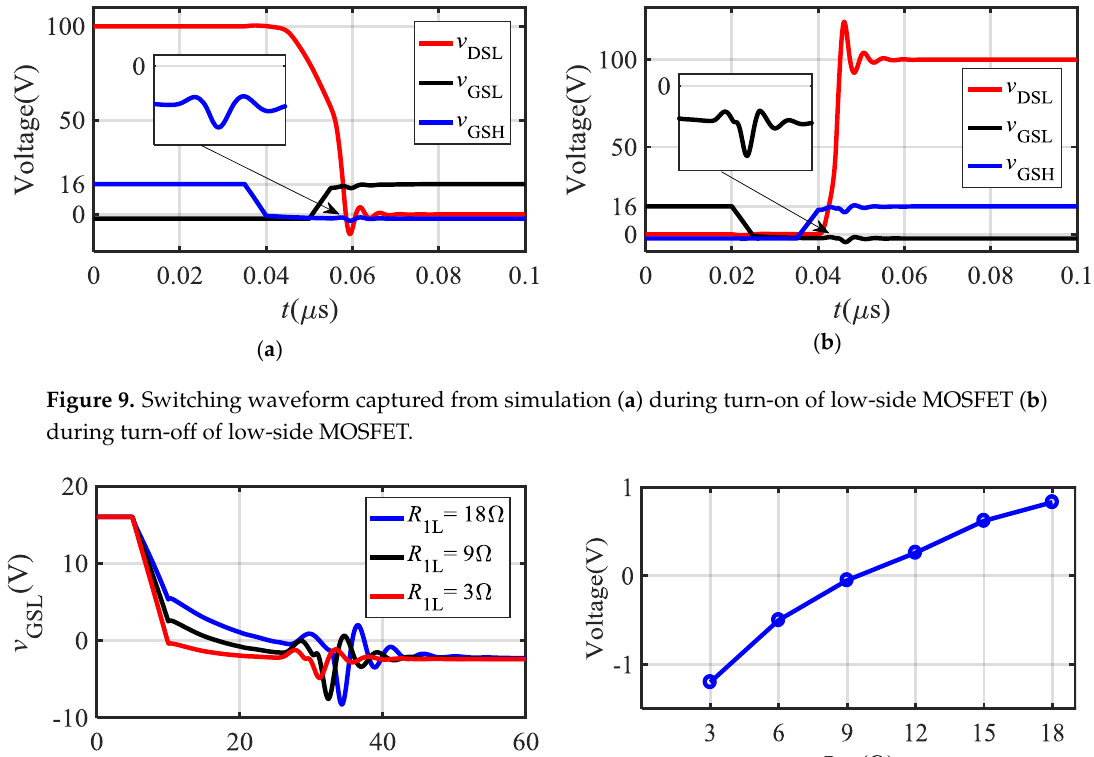
Figure 11. Simulation results of voltage ringing for different snubber cases ( a ) C SBR = 1 nF and R SBR = 3, 6 and 10 Ω ( b ) R SBR = 1 Ω and C SBR = 0.47, 2.2 and 4.7 nF.